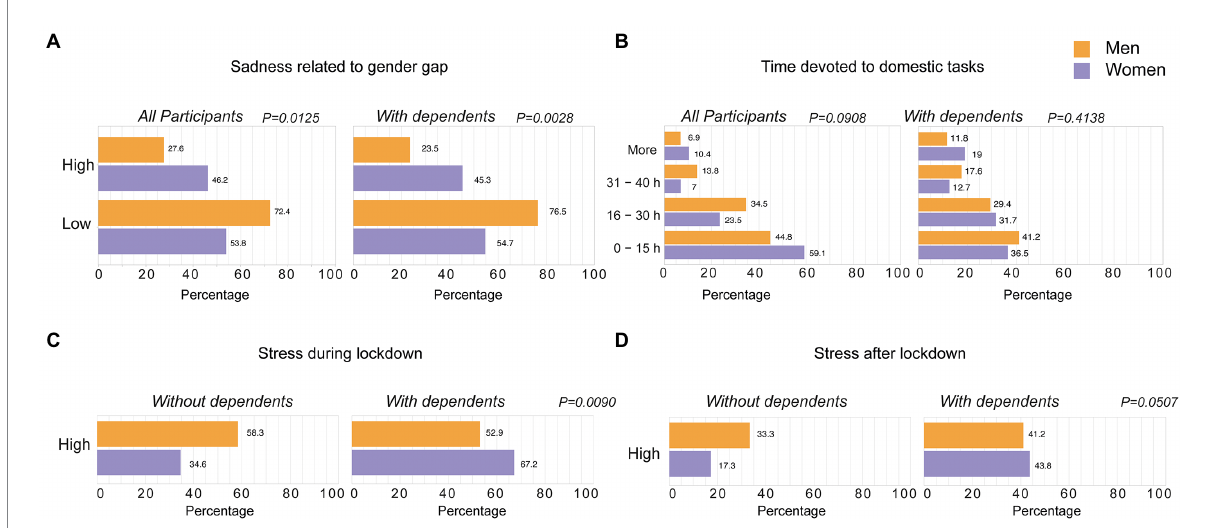
FIGURE 3 Impact of COVID-19 lockdowns on mental health and wellbeing of scientists. The self-reported mental health and wellbeing status or the indicated activities were analyzed (A) for all the participants ( n = 146) or for those with children or dependents in care ( n = 81). Numbers in each bar show the percentage of men (orange bars) and women (purple bars) who answered for each of the issues analyzed. The indicated wellbeing status was analyzed for those participants reporting high stress (B) during ( n = 77) or (C) after lockdown ( n = 48). Statistical differences in the distributions between men and women were analyzed with Fisher’s exact test (A,C,D) and Chi-squared test (B)